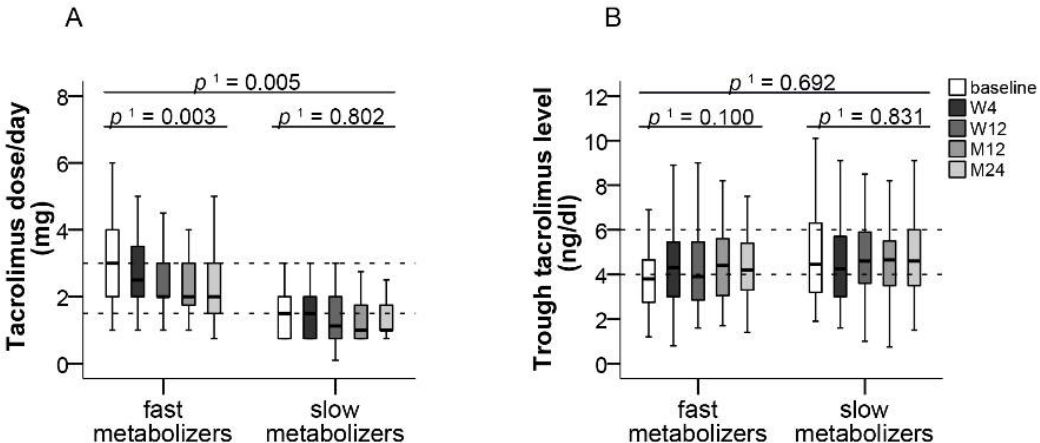
Figure 8. Tacrolimus dose and trough level in slow and fast metabolizers. Boxplots show median values with 95% CI for ( A ) tacrolimus dose and ( B ) tacrolimus trough level according to the categories of slow and fast metabolizers, both at the baseline visit as well as at weeks 4 and 12 and at months 12 and 24. 1 with Greenhouse–Geisser correction; M: month, W: week.